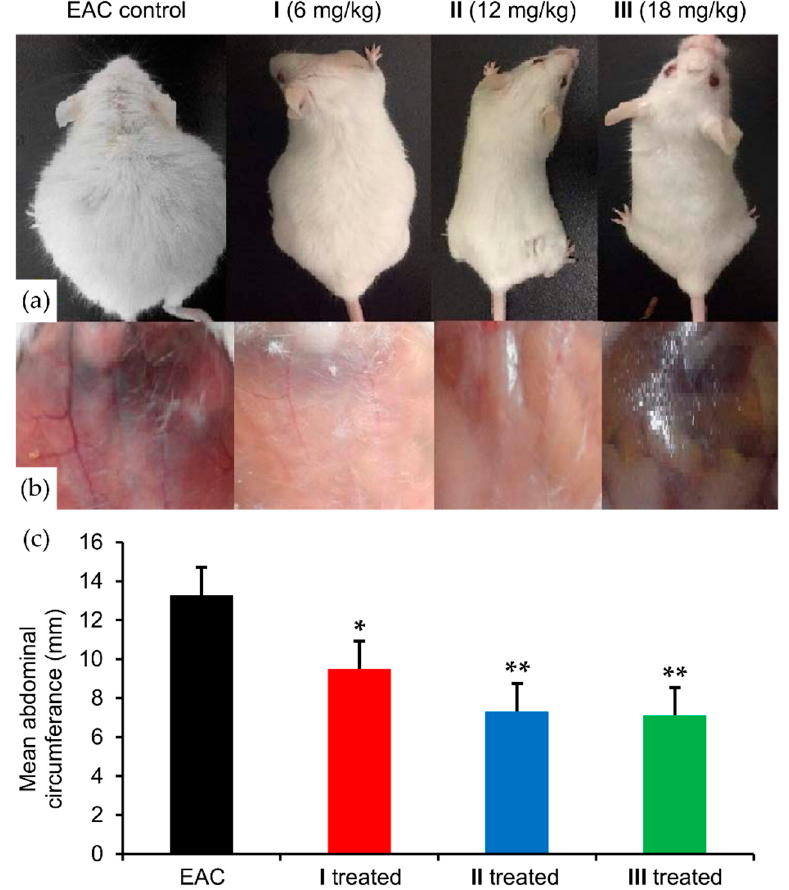
Figure 7. E ff ect of compound ( 2 ) on abdominal size and peritoneal angiogenesis. ( a ) From left to right Ehrlich Ascites Carcinoma (EAC), I (6 mg / kg), II (12 mg / kg), and III (18 mg / kg) treated mice; ( b ) from left to right, the peritoneal cavity of EAC, I , II , and III treated groups; ( c ) mean abdominal circumference of EAC, I , II , and III treated groups. Values (columns and error bars) are expressed as mean ± SEM. * and ** mean significant di ff erence at p < 0.05 and p < 0.001 compared to the EAC